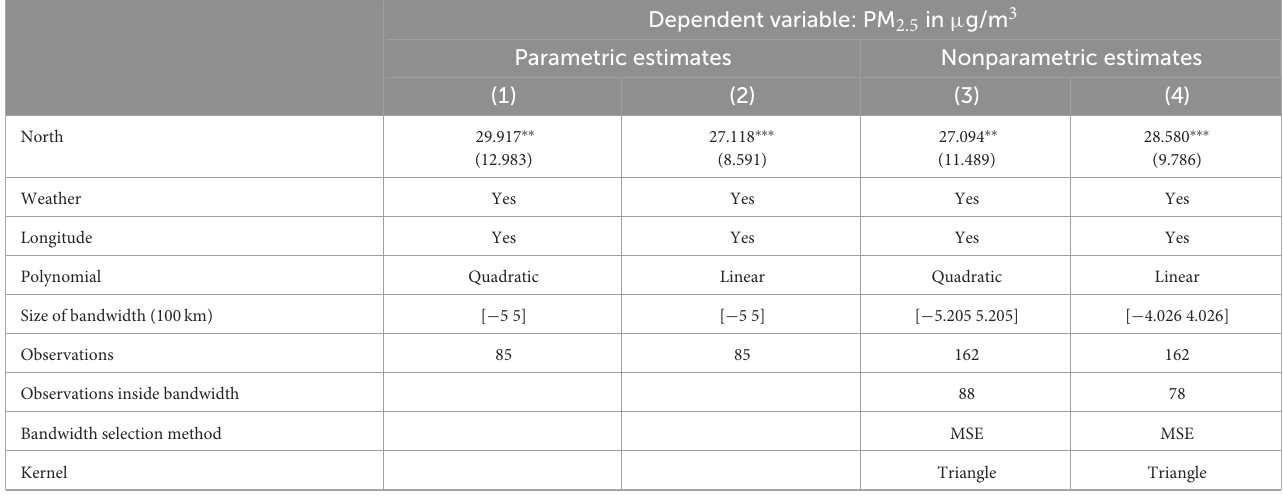
TABLE 2 RD estimates of the effect of the Huai River policy on PM 2.5